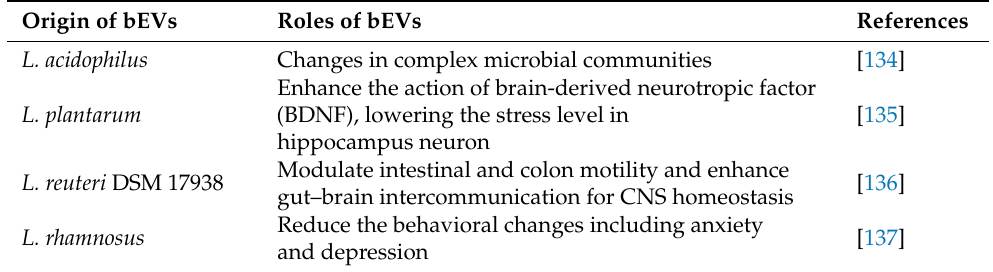
Table 4. Beneficial roles of probiotic-derived bEVs on gut–brain-axis control.